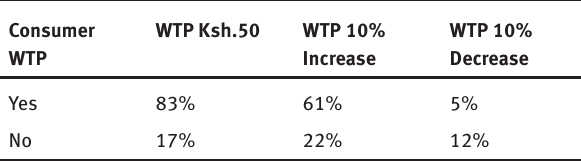
Table 5: Consumers’ willingness to pay for OFSP puree-wheat